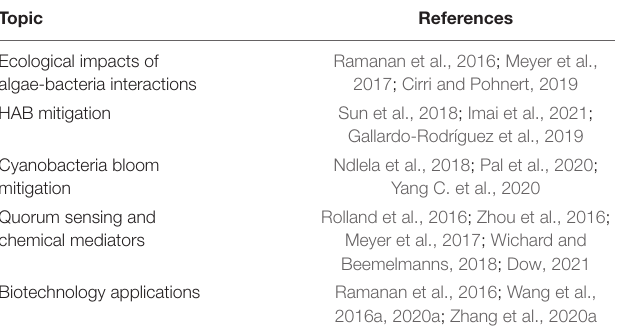
TABLE 1 | Selected recent reviews of algicidal